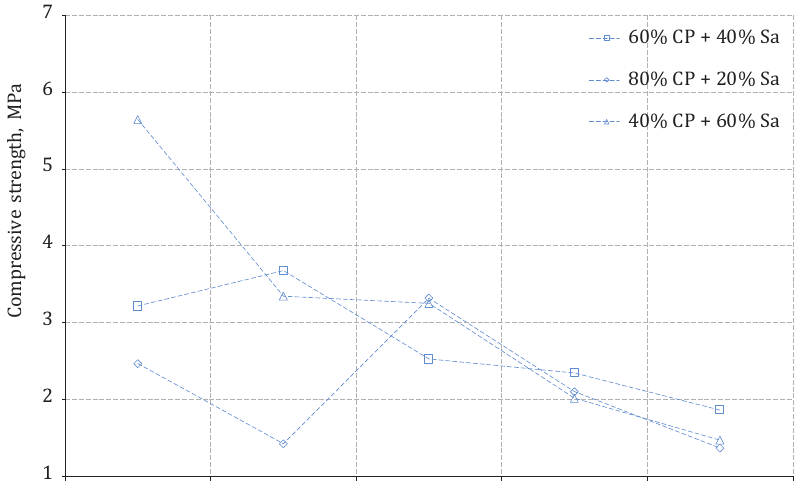
Figure 5. Fly ash effect on strength after 28 days (Zakarka et al.,